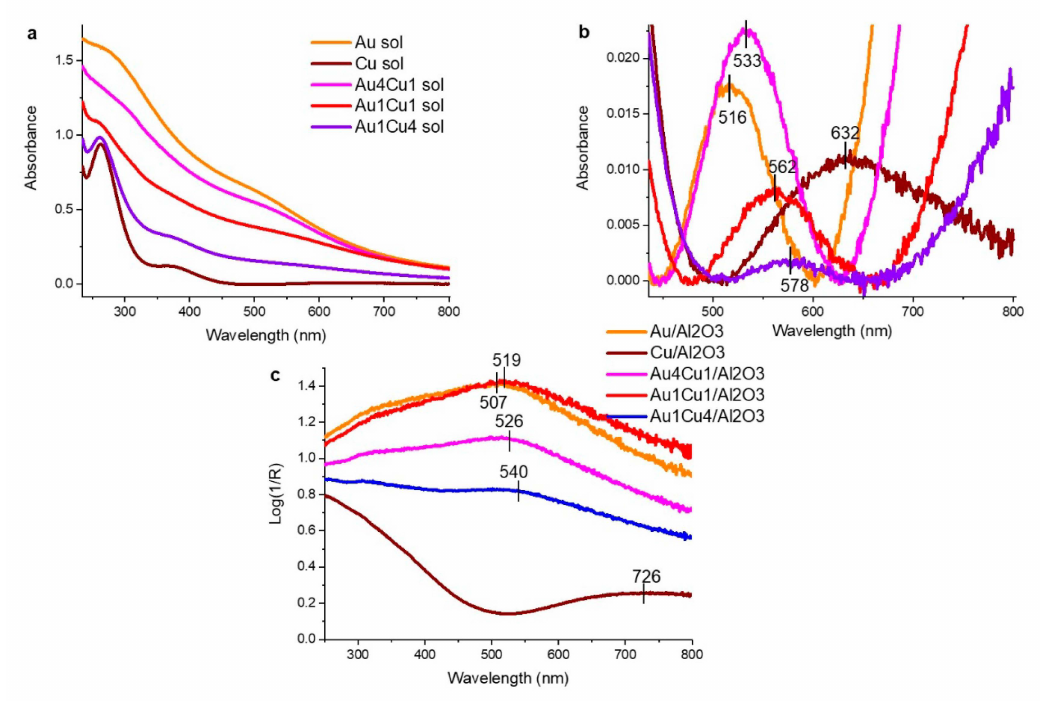
Figure 5. UV-vis spectra of the parent sols ( a ), the same spectra base line corrected in the localized surface plasmon resonance (LSPR) region ( b ) and of supported catalysts ( c